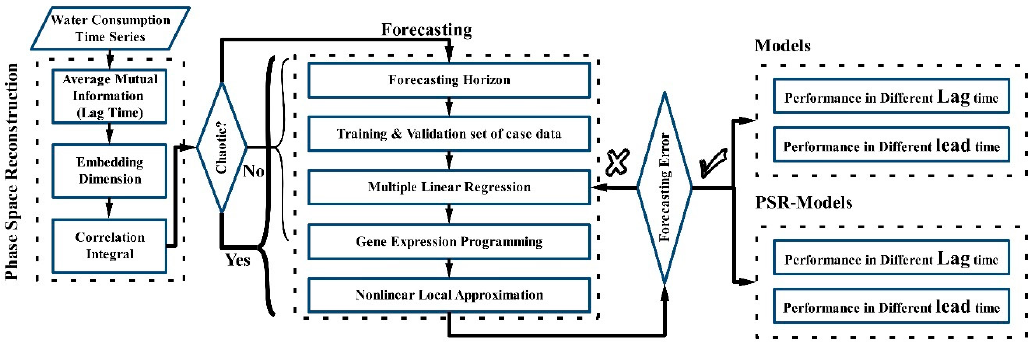
Figure 1. Research process scheme and methodology.